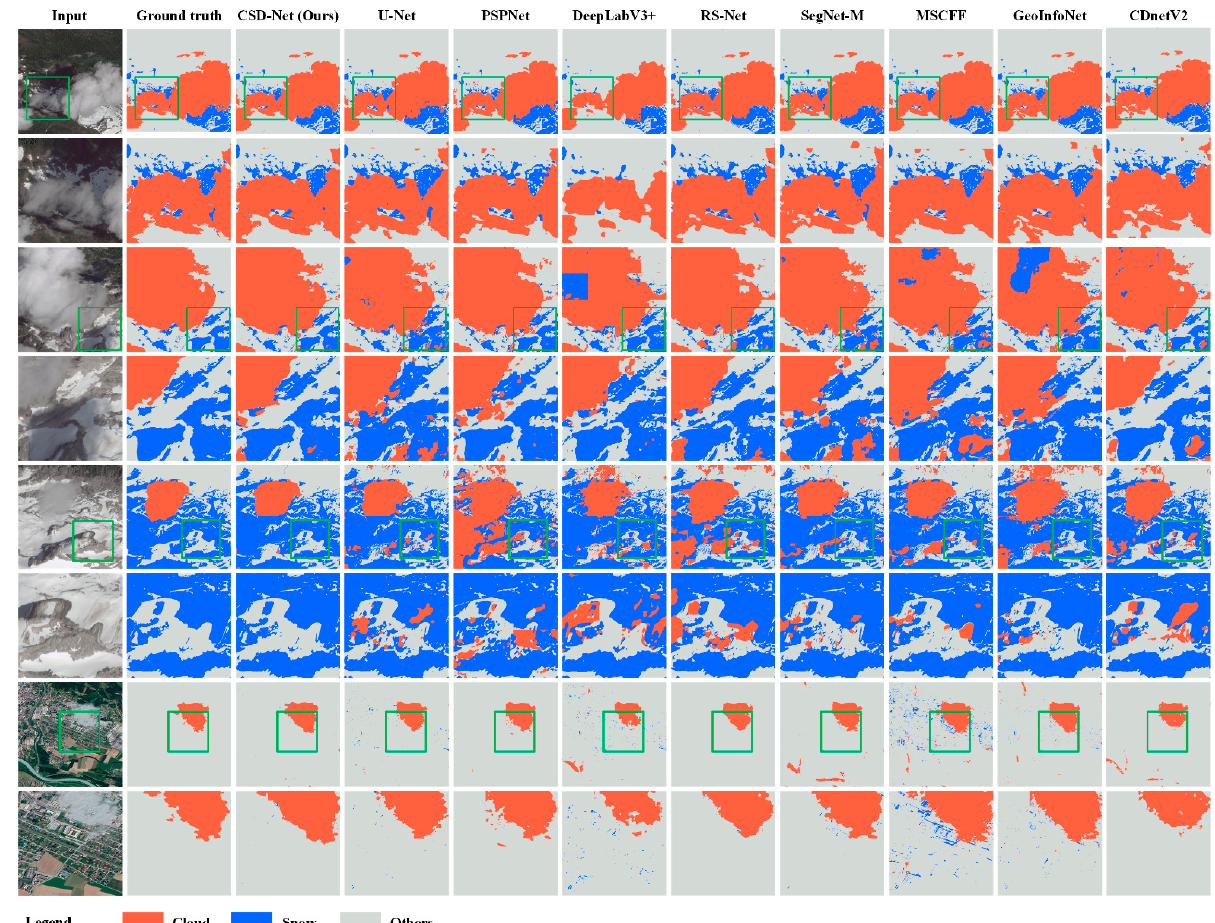
Figure 13. On the CSWV_S6 dataset, the visual comparison of cloud and snow detection results for several deep learning methods. It lists the original images, the detection results of various methods, and the ground truths one by one. The delineated areas with the green boxes were magnified to provide a more detailed visual comparison.